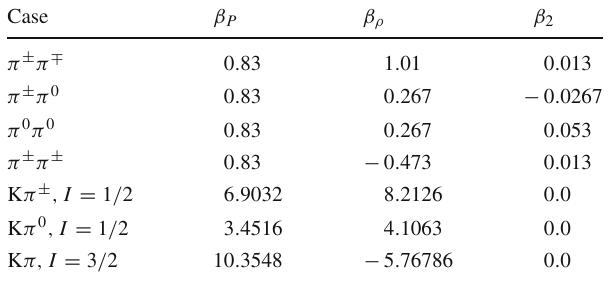
Table 2 Parameters for the H PR 1 R 2 parameterization, for processes used in our rescattering framework. All numbers are in units of mb. N stands for either p or n and K stands for either K − or K 0 Process